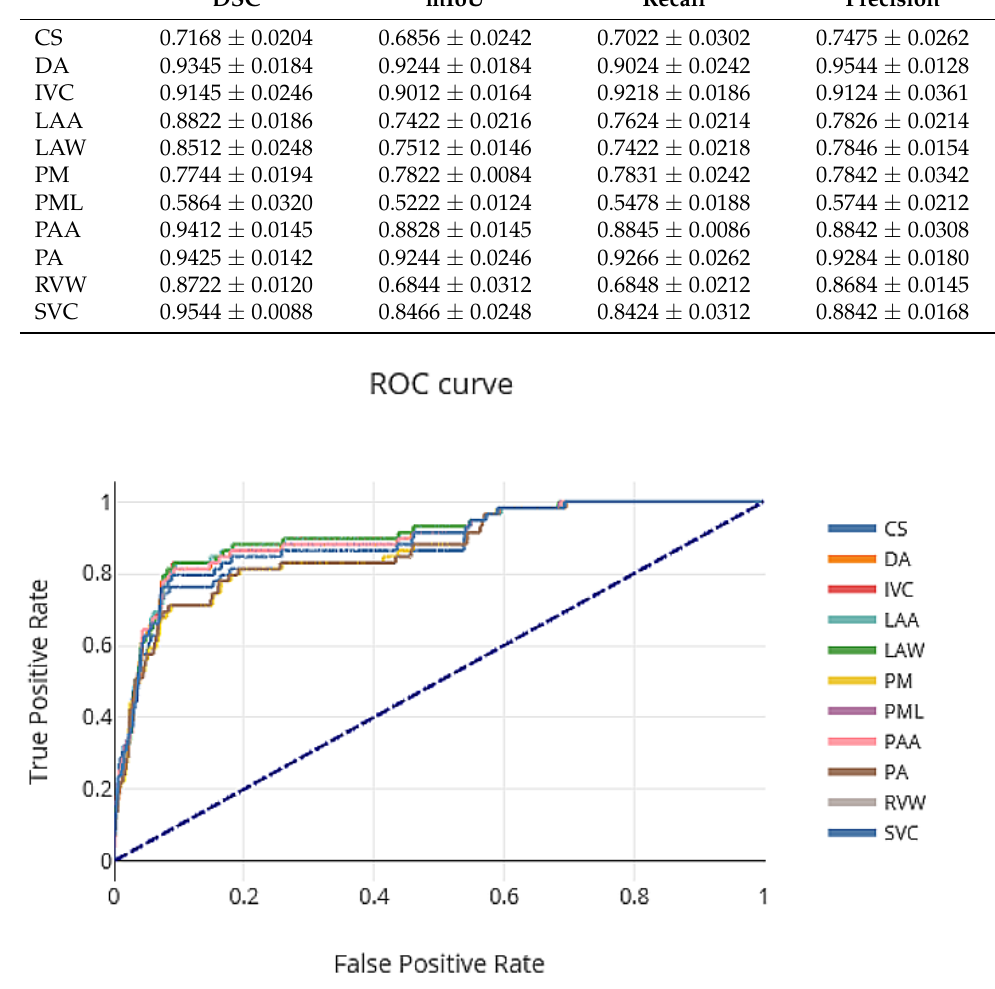
Figure 4. The ROC curve and AUC values for CS, DA, IVC, LAA, LAW, PM, PML, PAA, PA, RVW, and SVC dataset of our proposed segmentation method with AB-ResUNet+ network